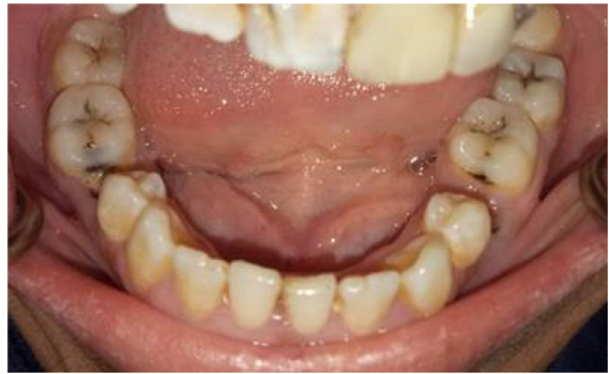
Fig. 6. Radiographs of 35 and 45 and an asymptomatic impacted 48.